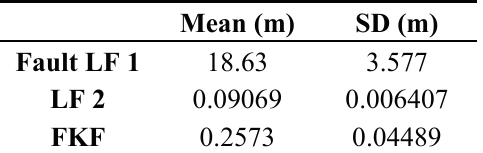
Figure 12. Target positioning errors when LF 1 fails. Table 3. Statistical analysis of positioning errors when LF 1